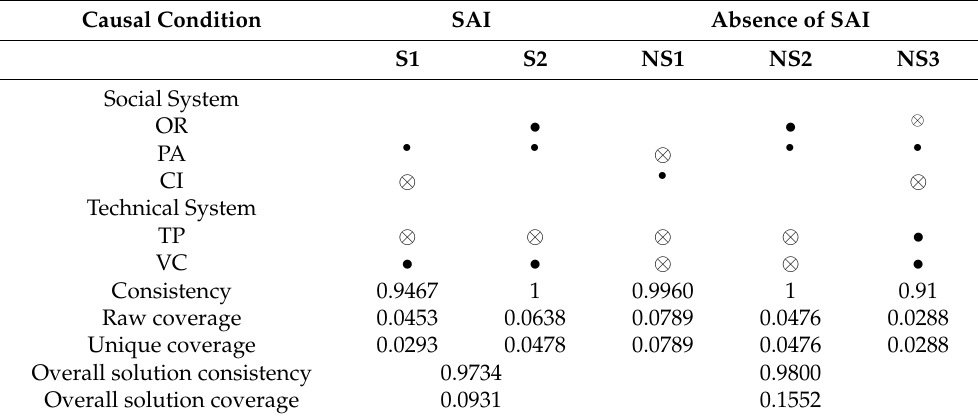
Table 4. Configurations for achieving strong account influence or absent